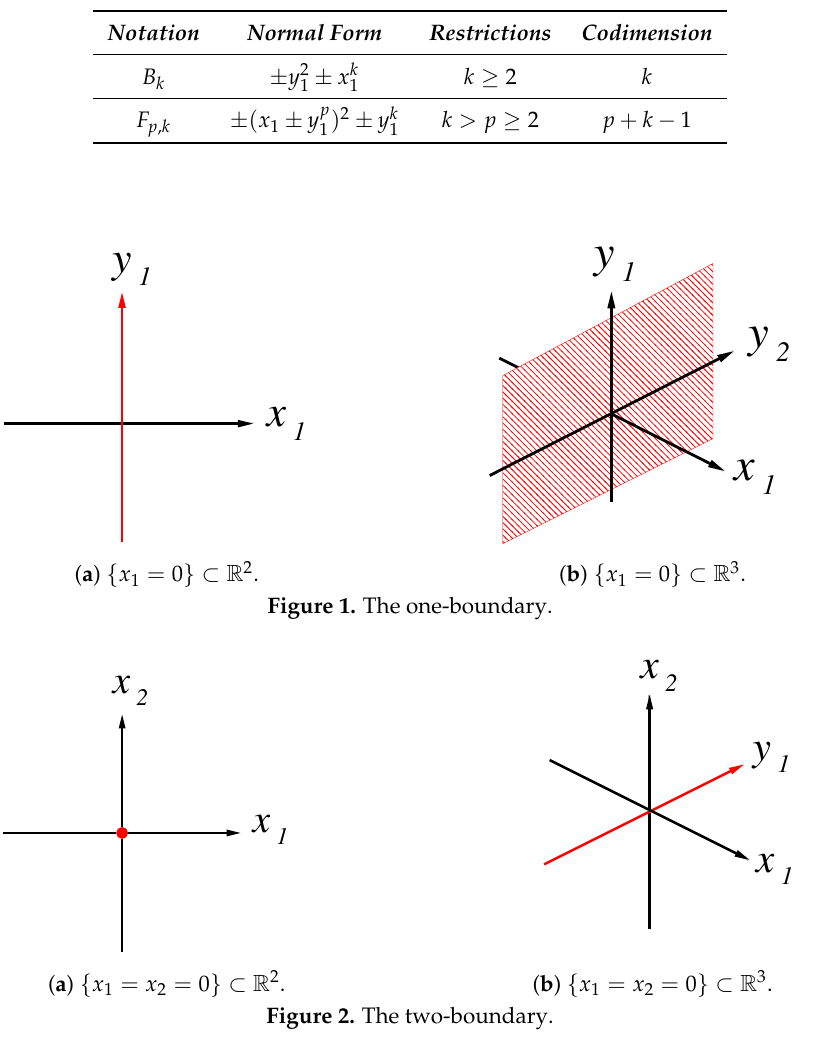
Figure 1. The one-boundary.